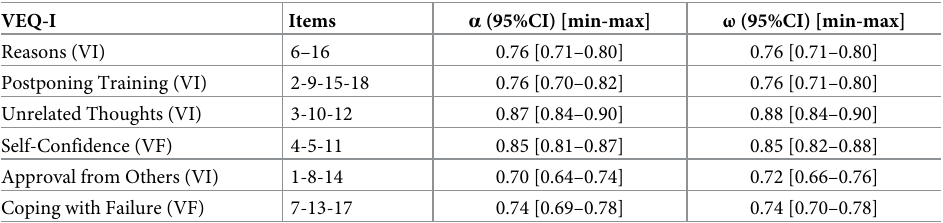
Table 2. Reliability values of VEQ-I in 6